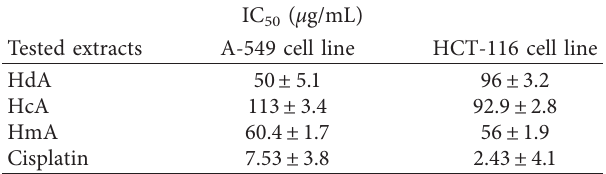
Figure 4: In vitro cytotoxic activity of aqueous extracts of tested Hibiscus deflersii (HdA), H. micranthus (HmA), and H. calyphyllus (HcA) against A-549 (a) and HCT-116 (b) cell lines. Table 2: IC 50 of tested aqueous extracts of Hibiscus deflersii (HdA), H. micranthus (HmA), and H. calyphyllus (HcA) against A-549 and HTC-116 cell